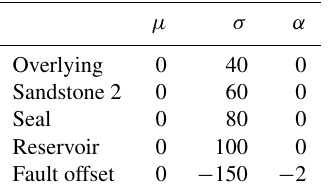
Table 1. Input parameter uncertainties defined by distributions with respective means µ , standard deviations σ , and shape factor α